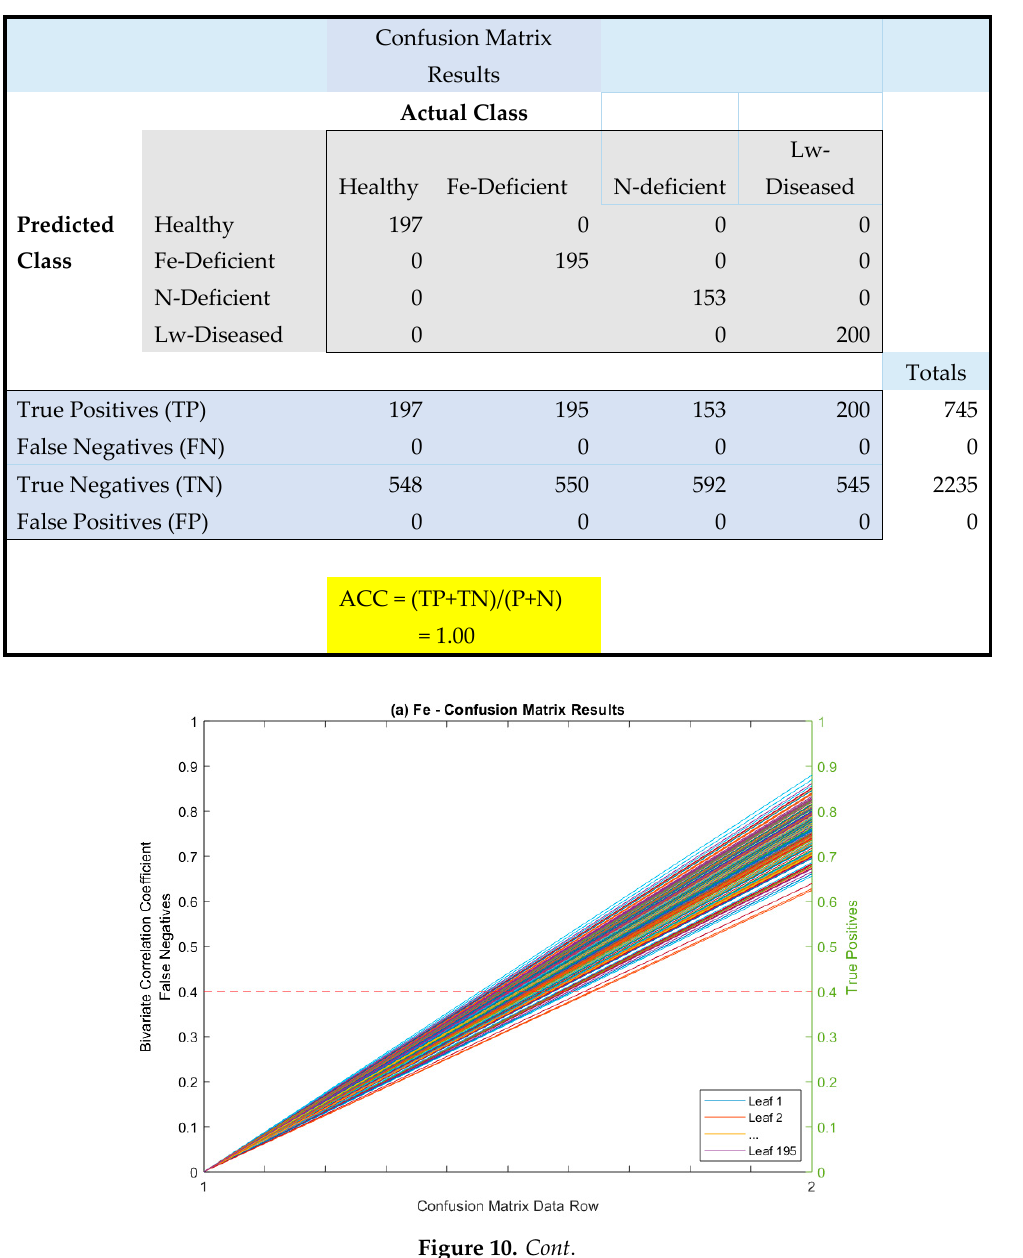
Figure 10. FDA-BC algorithm results of Confusion Matrix. Table 2. Summary of Confusion Matrix; Accuracy: 100%. Table 2. Summary of Confusion Matrix; Accuracy: